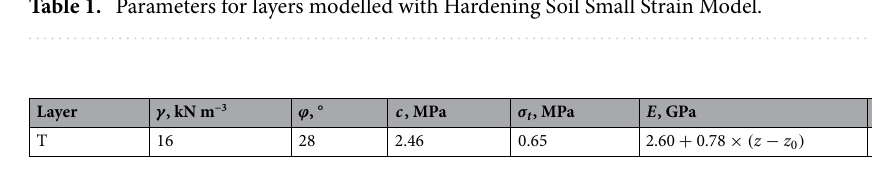
Table 2. Parameters for layers modelled with Mohr–Coulomb Model.